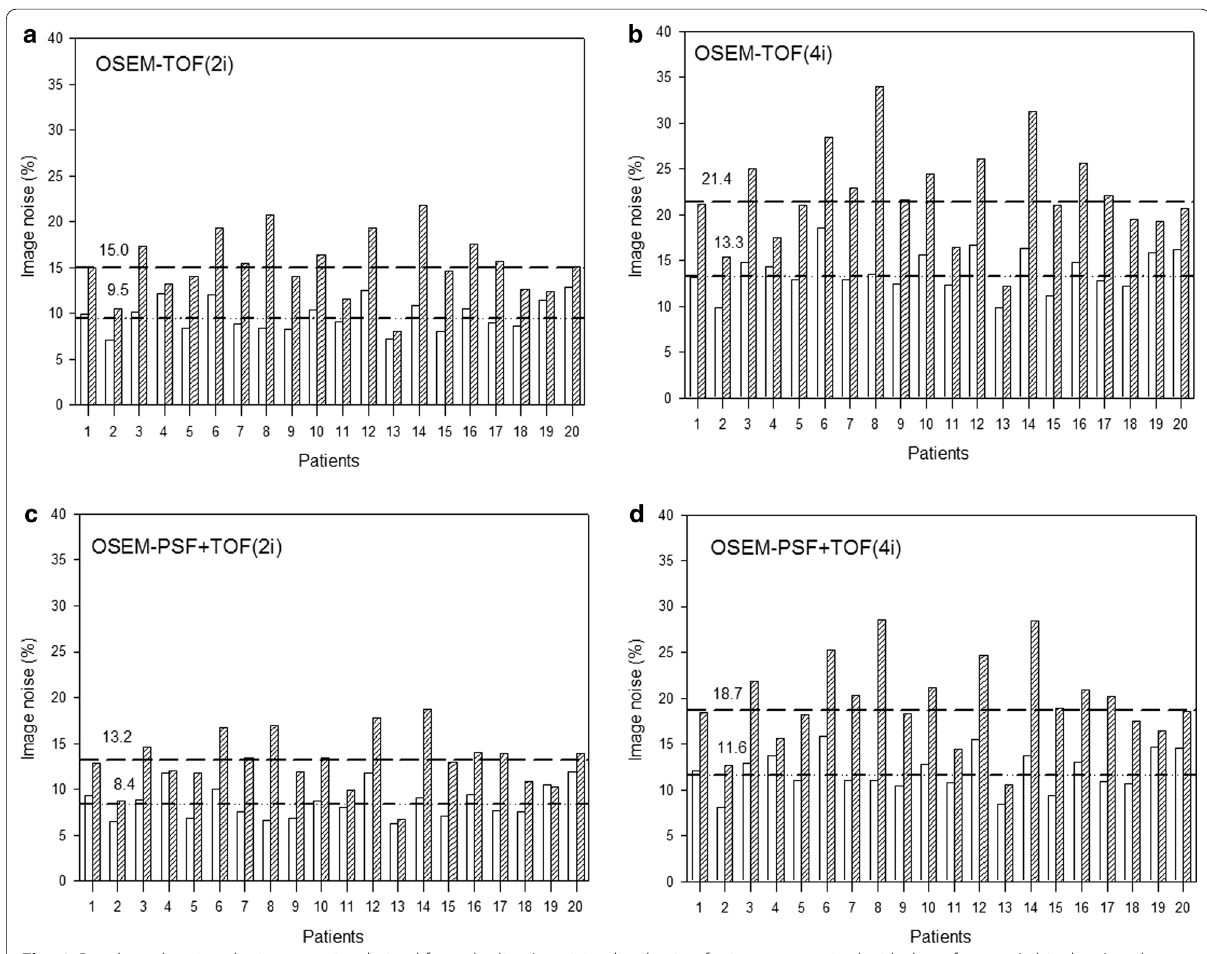
Fig. 6 Bar chart showing the image noise derived from the liver’s activity distribution for images acquired with the reference (white bars) and reduced protocol (hatched bars) and reconstructed with different reconstruction algorithms ( a – d ). Medians are illustrated using dashed lines and the respective numbers are close to the